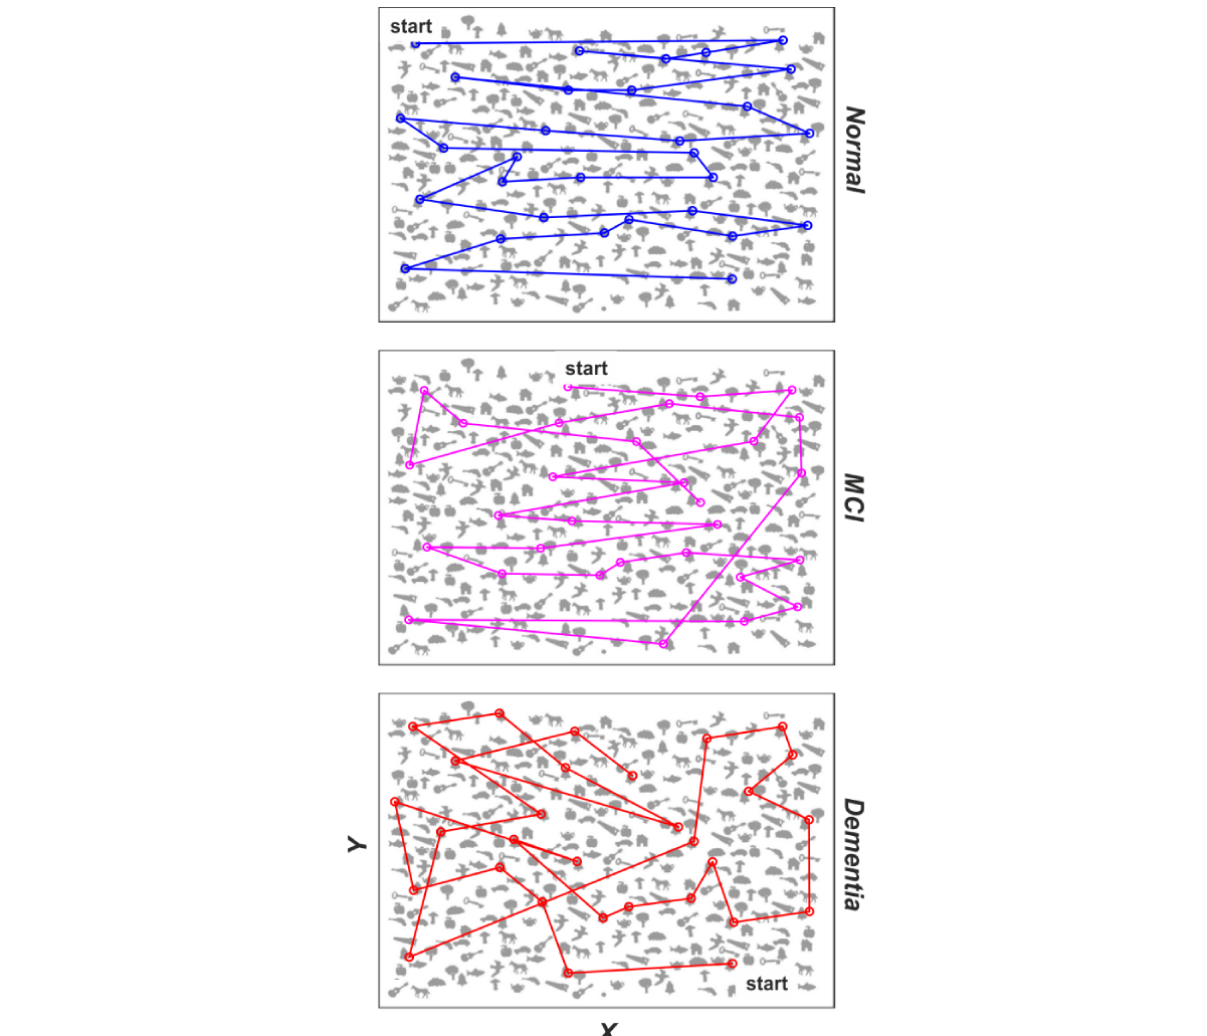
Figure 6. Examples of scanning strategies during the digitized Bells Test for 3 subjects, one for each diagnosis group; from top to bottom: normal (NIDmin=0), mild cognitive impairment (NIDmin=2), and dementia (NIDmin=4). MCI: mild cognitive impairment; NIDmin: minimum number of inversions in the